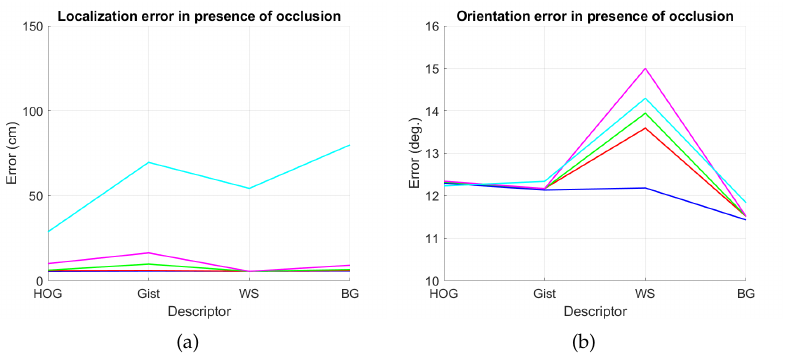
Figure 45. Average errors with the COLD dataset in the presence of occlusions. ( a ) Average position error (cm) and ( b ) average orientation error (deg). Legend : —– Original, —– Occlusion 1,